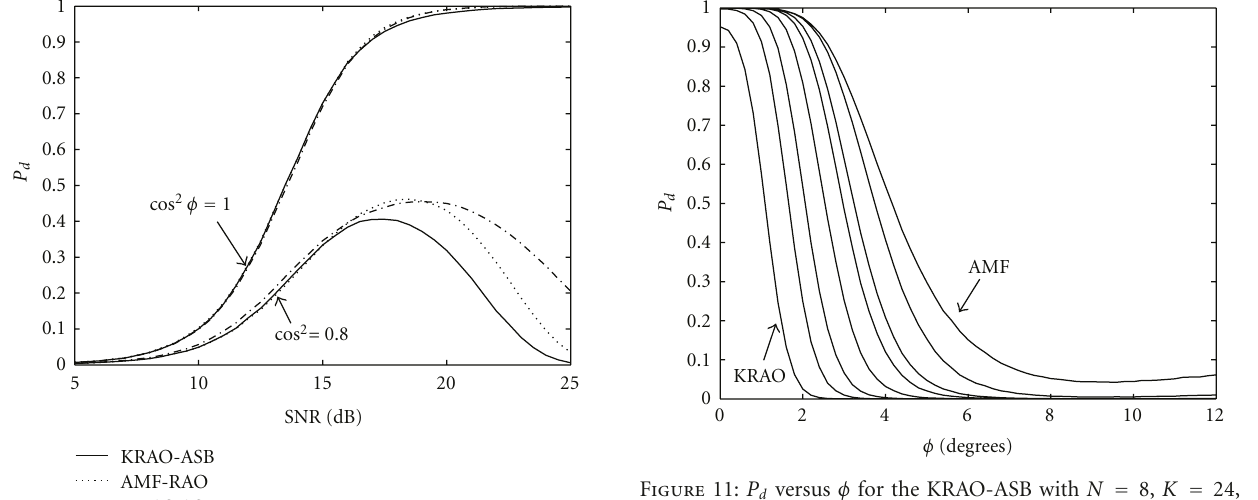
K = 24, ρ = 1 . 2, H = [ s (0), s ( π/ 360)], P